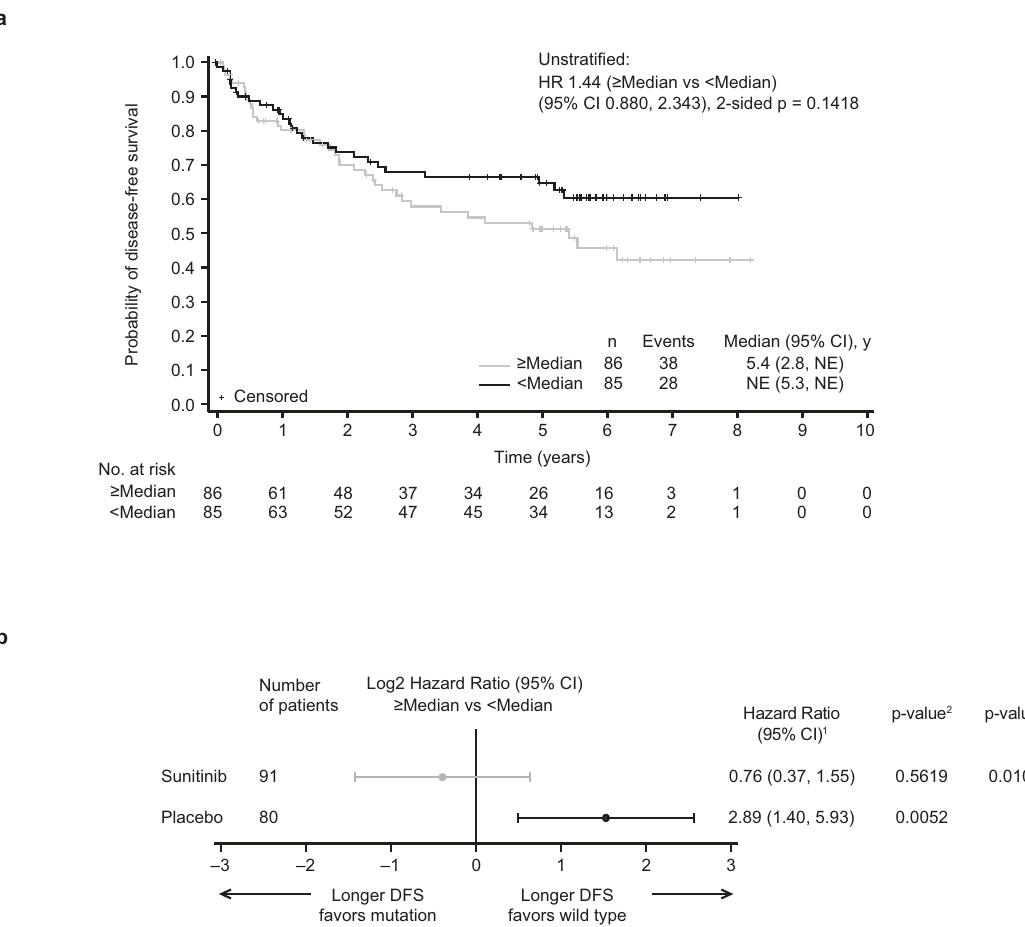
survival in the <Median group. HR reference level is <median, p -value is from Logranktest. 3 Two-sided p -valueforoverallmediancutoff-by-treatmentinteraction from Cox model with treatment group and median cutoff status as two indepen- dentvariables.CIcon fi denceinterval,DFSdisease-freesurvival,HRhazardratio,NE not estimable, TMB tumor mutational